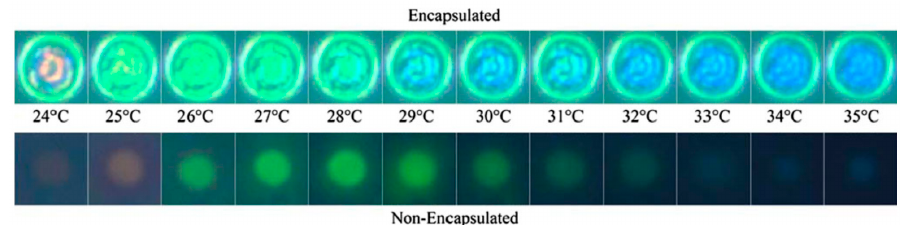
11 of 55 Figure 8. Typical calibration curve of TLC. Data from Muwanga and Hassan [ 73 ] . TLCs can be deposited as a layer on a surface or used to produce encapsulated or non-encapsulated temperature-sensitive tracer particles to seed a fluid. In the encapsu- lated version, an external polymer coating is present around the TLCs droplets. Therefore, they can form particles or protective microcapsules whose size can vary from the order of micrometer to millimeter and are usually in the range of 5 to 10 μ m. The polymer shell protects the TLC from external contamination, such as water, but causes light aberrations